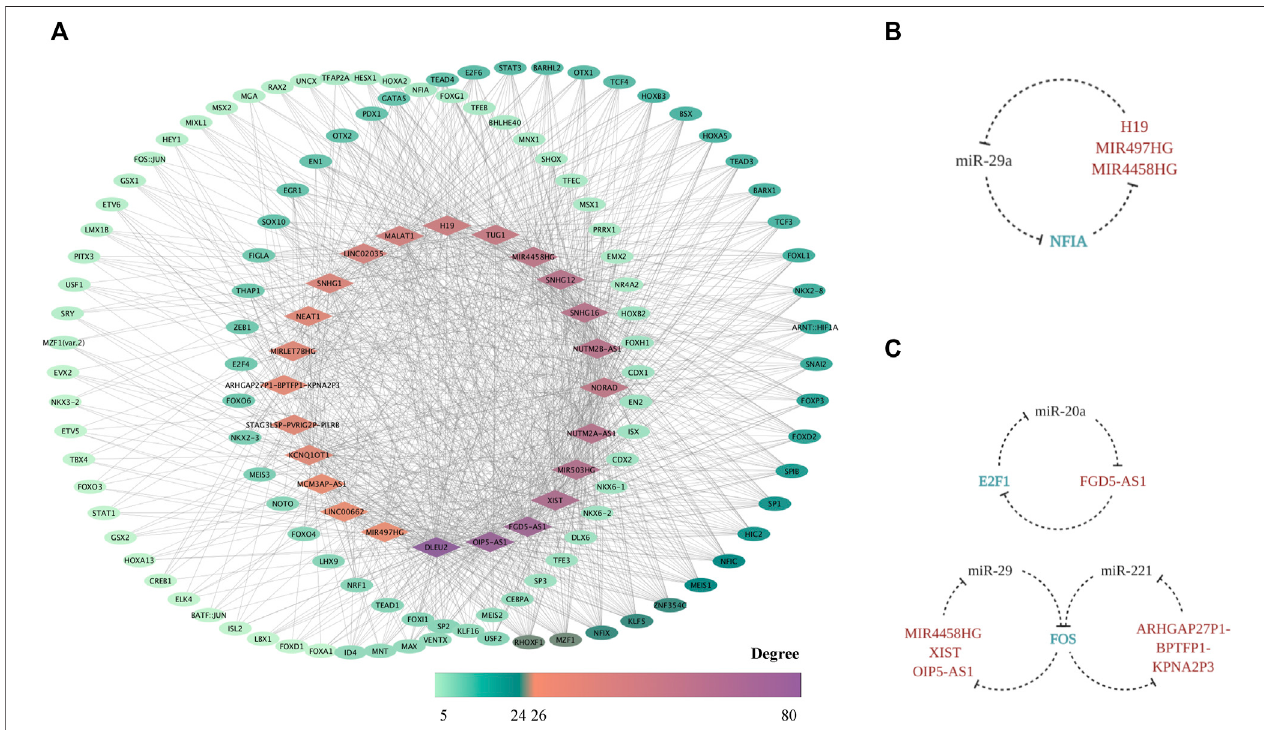
FIGURE 7 | The FR TF – lncRNA regulatory network. The TF – FR lncRNA network is visualized with lncRNAs forming the middle circle while TFs with degree < 10 standing on the left and those with degree ≥ 10 on the right. Node colors are mapped to degree scores. (A) The feedback loops based on the triplet of TF (FS mRNA) – CFS miRNA – FR lncRNA (B) as well as the triplet of TF (FTS mRNA) – CFS miRNA – FR lncRNA (C) are